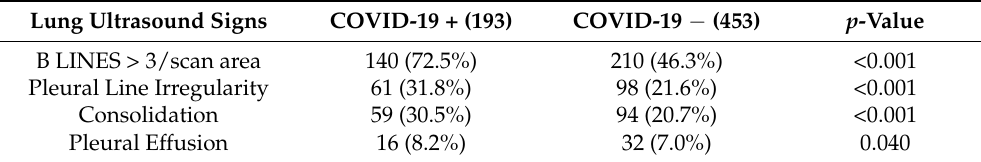
Table 2. Findings of the four main pathological lung ultrasound signs and comparison between the two groups; categorical variables are presented as frequencies and percentages, and they were compared using the chi-squared test with Yate’s correction.